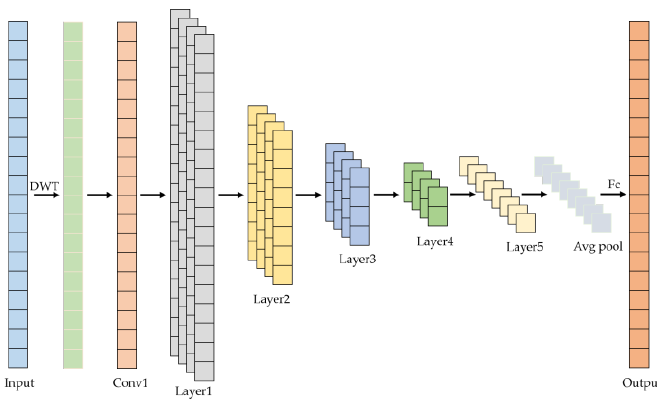
Figure 1. The network structure of DWT-Resnet.